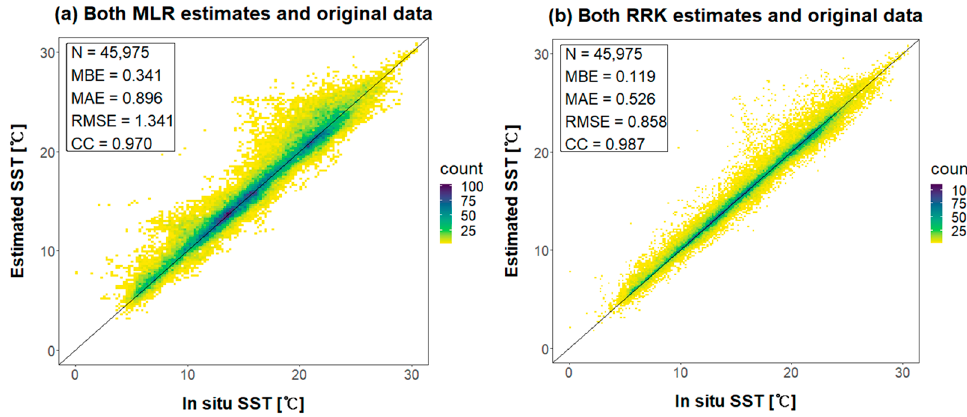
Figure 13. Scatter plots for the whole in situ measurement points (N = 45,975). ( a ) including both MLR estimates and original data, and ( b ) including both RRK estimates and original data.